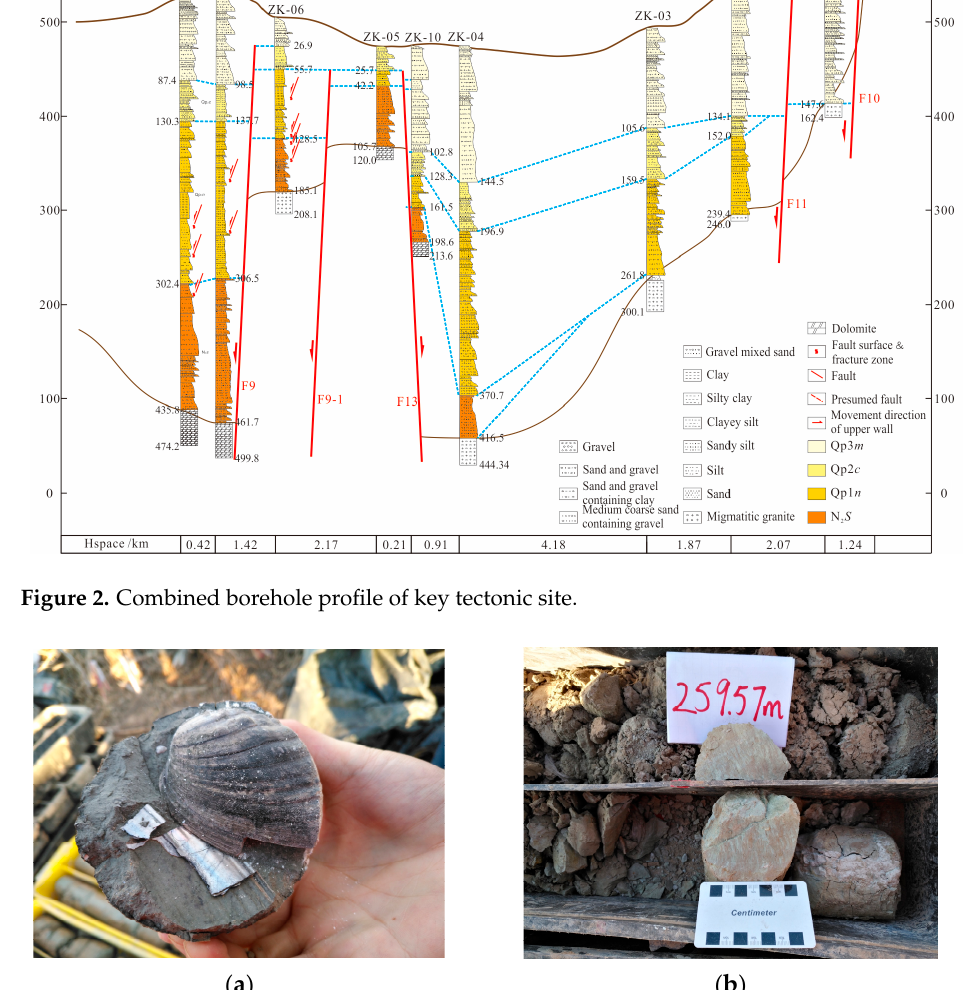
Figure 3. Typical core characteristics and fault slip surface. ( a ) Core containing shells; ( b ) fault slip surface. Table 1. OSL dating parameters and test results of samples.